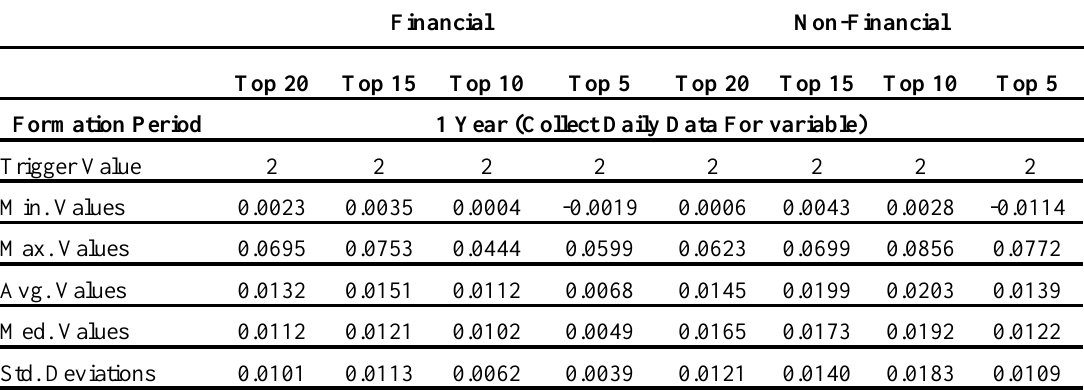
Table.1. Descriptive Analysis under Distance Method